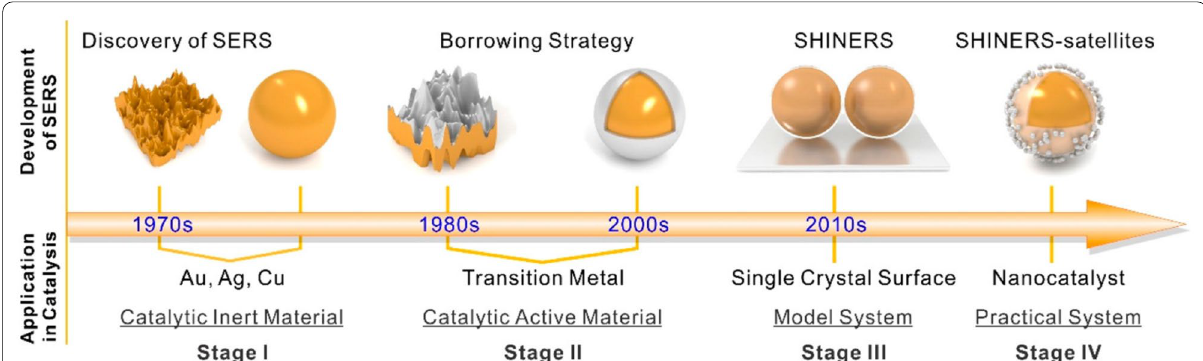
Fig. 2 The historical illustration of surface-enhanced Raman spectroscopy for the catalysis application. Discovery of SERS (stage I), borrowing strategy for non-plasmonic active materials (stage II), application of SHINERS on single crystalline surface as a model system (stage III), and practical system of SHINERS with satellite structure of nanocatalysts (stage IV), reproduced with permission from [27]. Copyright (2020) American Chemical